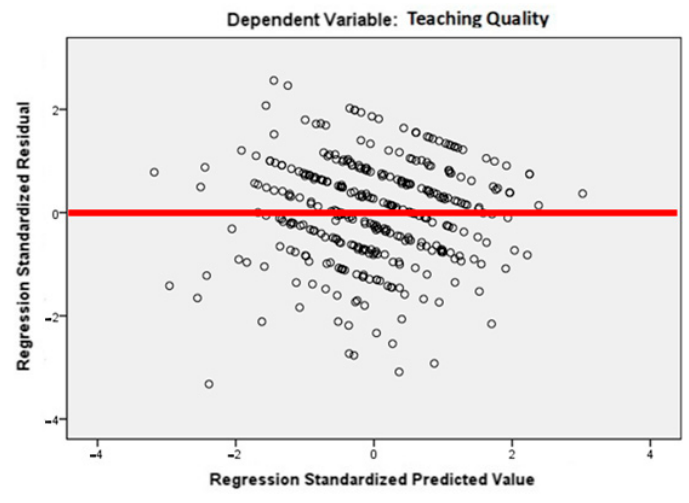
Figure 2. Scatter plot.